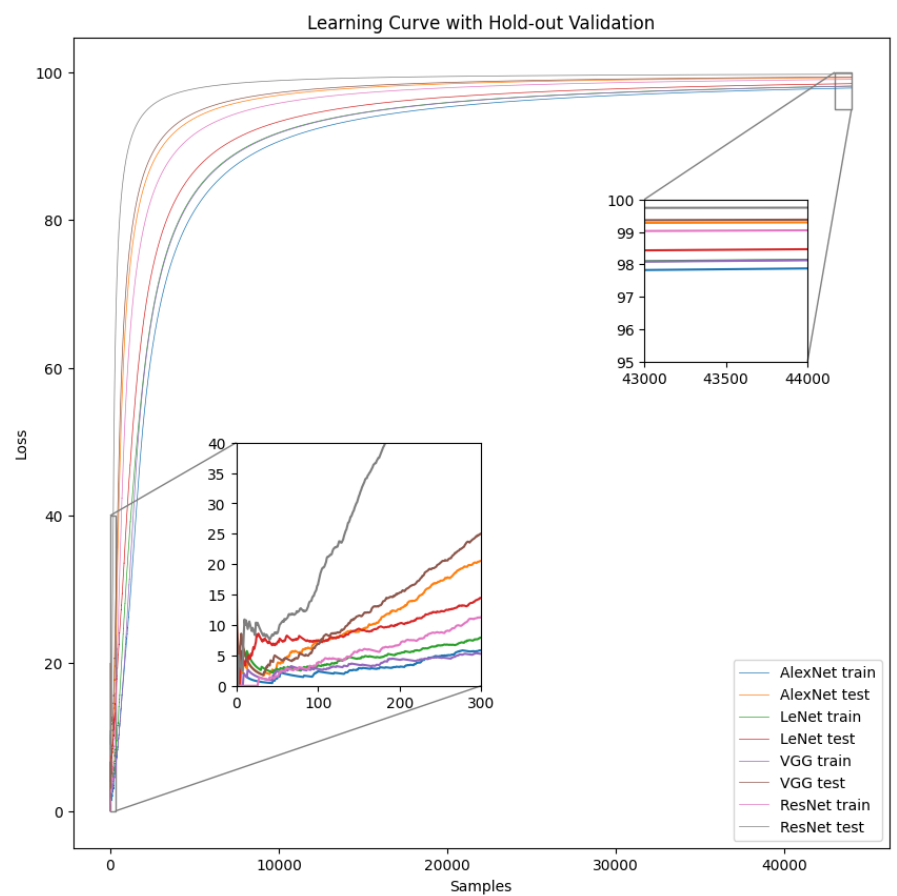
Figure 17. Learning curve comparisons for the LeNet training process, LeNet testing process, AlexNet training process, AlexNet testing process, VGG training process, VGG testing process, ResNet training process, and ResNet testing